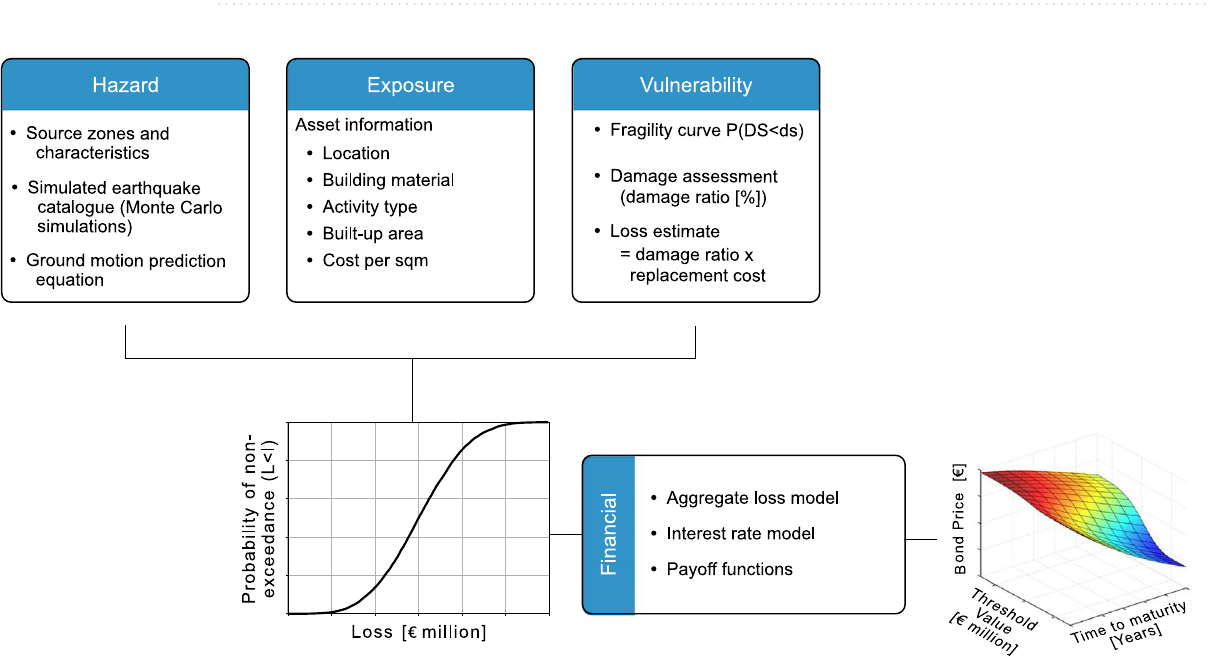
Figure 7. Methodology flow chart for pricing of risk-based catastrophe bonds: hazard, exposure, vulnerability and financial